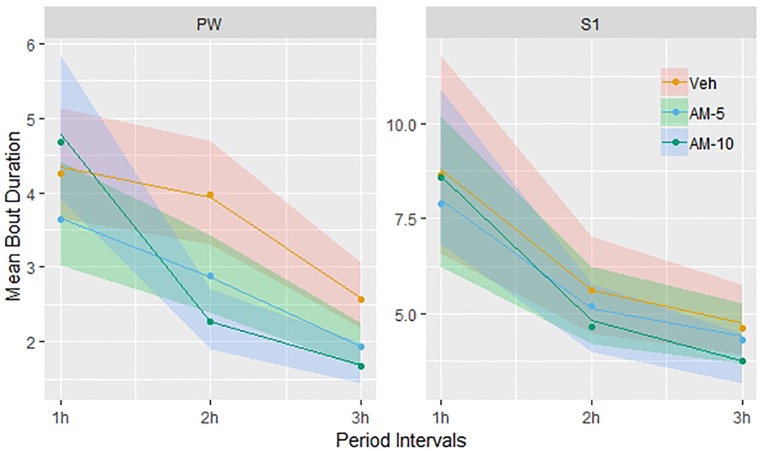
Dependence of bout durations on time and treatment was modeled using linear mixed regression. Before the analysis, bout durations were transformed logarithmically and the linear model included time and treatment and their interactions as categorical variables. The figure shows the observed means and the back-transformed confidence intervals of the fitted means (shown by colored stripes). The time trends are visually different but the time x treatment interaction is significant only for PW and only in the 10-mg/kg dose group.